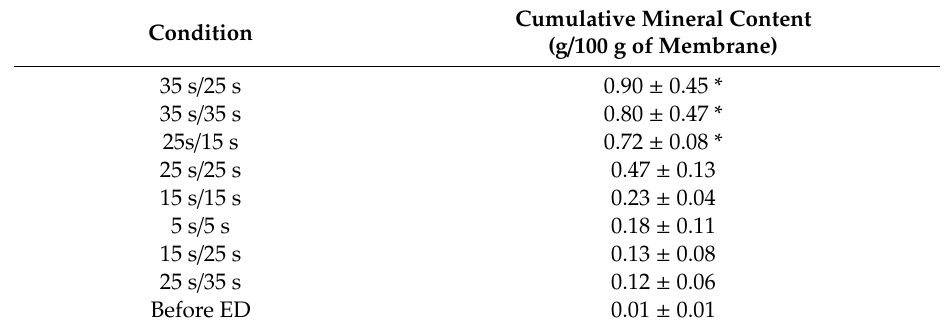
Table 3. AEM’s cumulative mineral content for a pristine membrane and the eight PEF conditions after 3 hours of e ff ective current application during the ED treatment of acid